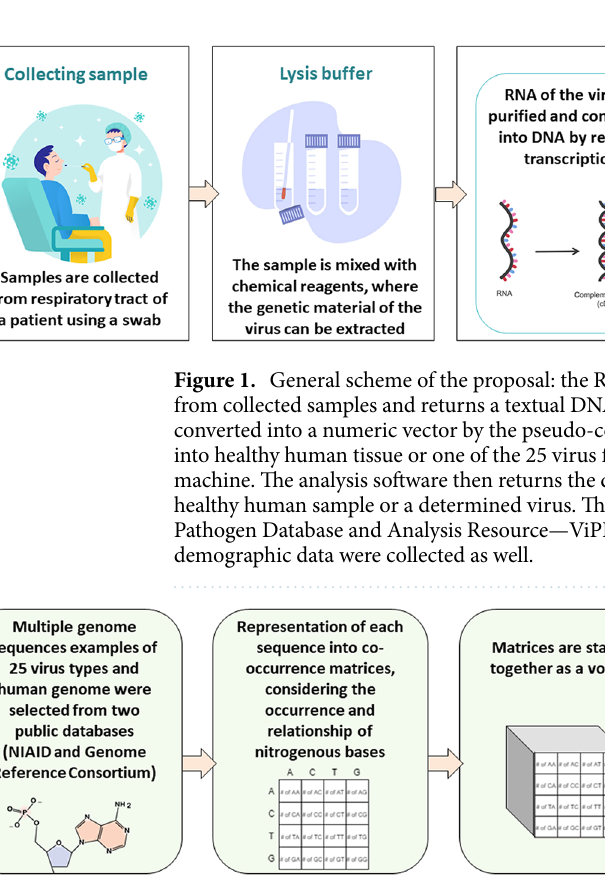
Figure 2. Detailed contribution: 25 classes are used to train the classifiers: 24 virus families and SARS-CoV-2 sequences. Each sequence is analysed, being divided into several sub-sequences considering with a determined degree of overlapping. Each sub-sequence is then represented by 4 distribution of nucleotides neighborhoods. The 4 feature vector used as input for the